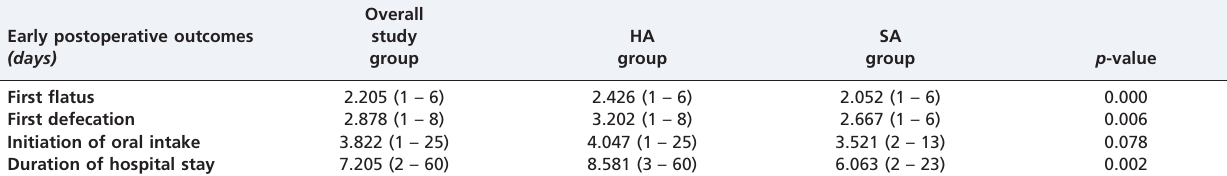
Table 2 - A comparison of the early postoperative outcomes of stapled (SA) versus handsewn (HA) loop ileostomy